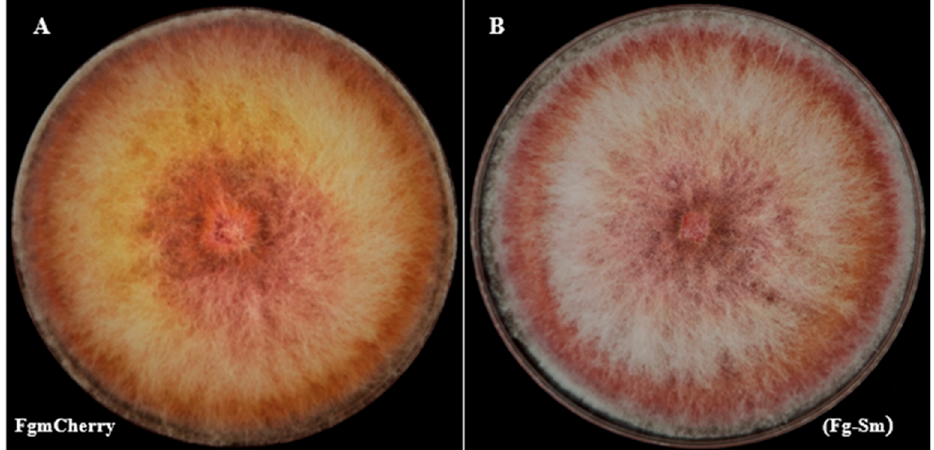
Figure 3. Morphology of FgHis1mCherry strain (FgmCherry) ( A ) compared with the Fg- S. malto- philia (Fg-Sm) isolate ( B ). Both were grown on DFM medium supplemented with gentamicin 0.512